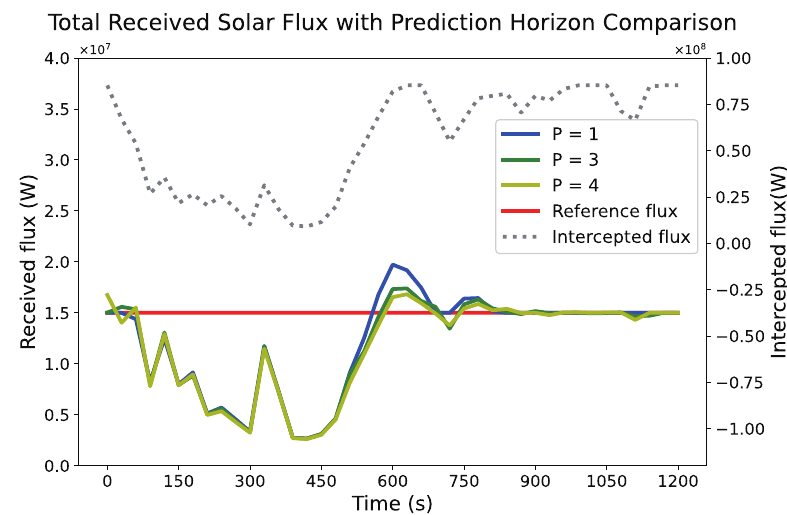
Figure 7. The performance analysis of the MPC-based aiming strategy between different predic- tion